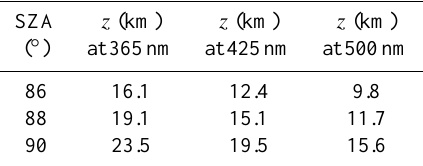
Table B1. Mean scattering height ( z ) for zenith-sky measurements at various SZA and